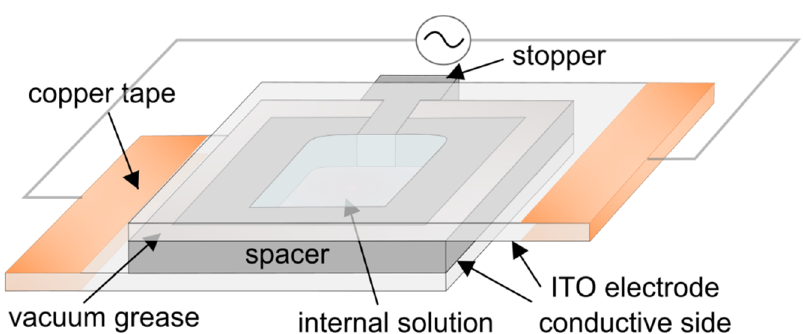
Figure 2. Schematic representation of the electroformation chamber used in the experiments.